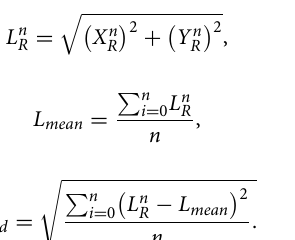
Figure 3. ( A ) A child’s key points in one frame image. ( B ) The local image of the child in Fig. 3A includes his whole-body key points and his neck key point (referring to key point 1) pixel coordinates. ( C ) The corresponding relationship between human joins and 25 key points extracted by OpenPose 24 . ( D ) The trajectory tracking of the neck key point of a child in the view of the camera with an interval of 20 s during t 1 and t 8 . ( E ) The pixel distance (PD) and instantaneous pixel velocity (IPV) calculation process for the neck key Movement features (MFs). Figure 3E is taken to illustrate pixel distance (PD) and instantaneous pixel velocity (IPV) MF calculations. In Fig. 3E, point A is the center of the table’s edge next to the participant, defined as the origin point, point B is the neck key point’s coordinates of a child in the frame of the video captured at the sampled time n , and point C is the neck key point’s coordinates of a child in the frame captured at the sample n Y n L n time n + 1 . X R and R are the PD between point B and point A on the x-axis and y-axis, respectively. R is the n n direct PD between point B and point A in frame n . δ X and δ Y are the IPV between point B (in frame n ) and n point C (in frame n + 1 ) in x-axis and y-axis, respectively, and δ L is the IPV between point B and C. L mean and L std are the mean and standard deviation of L n R , which are the MFs based on PD and can be expressed as: